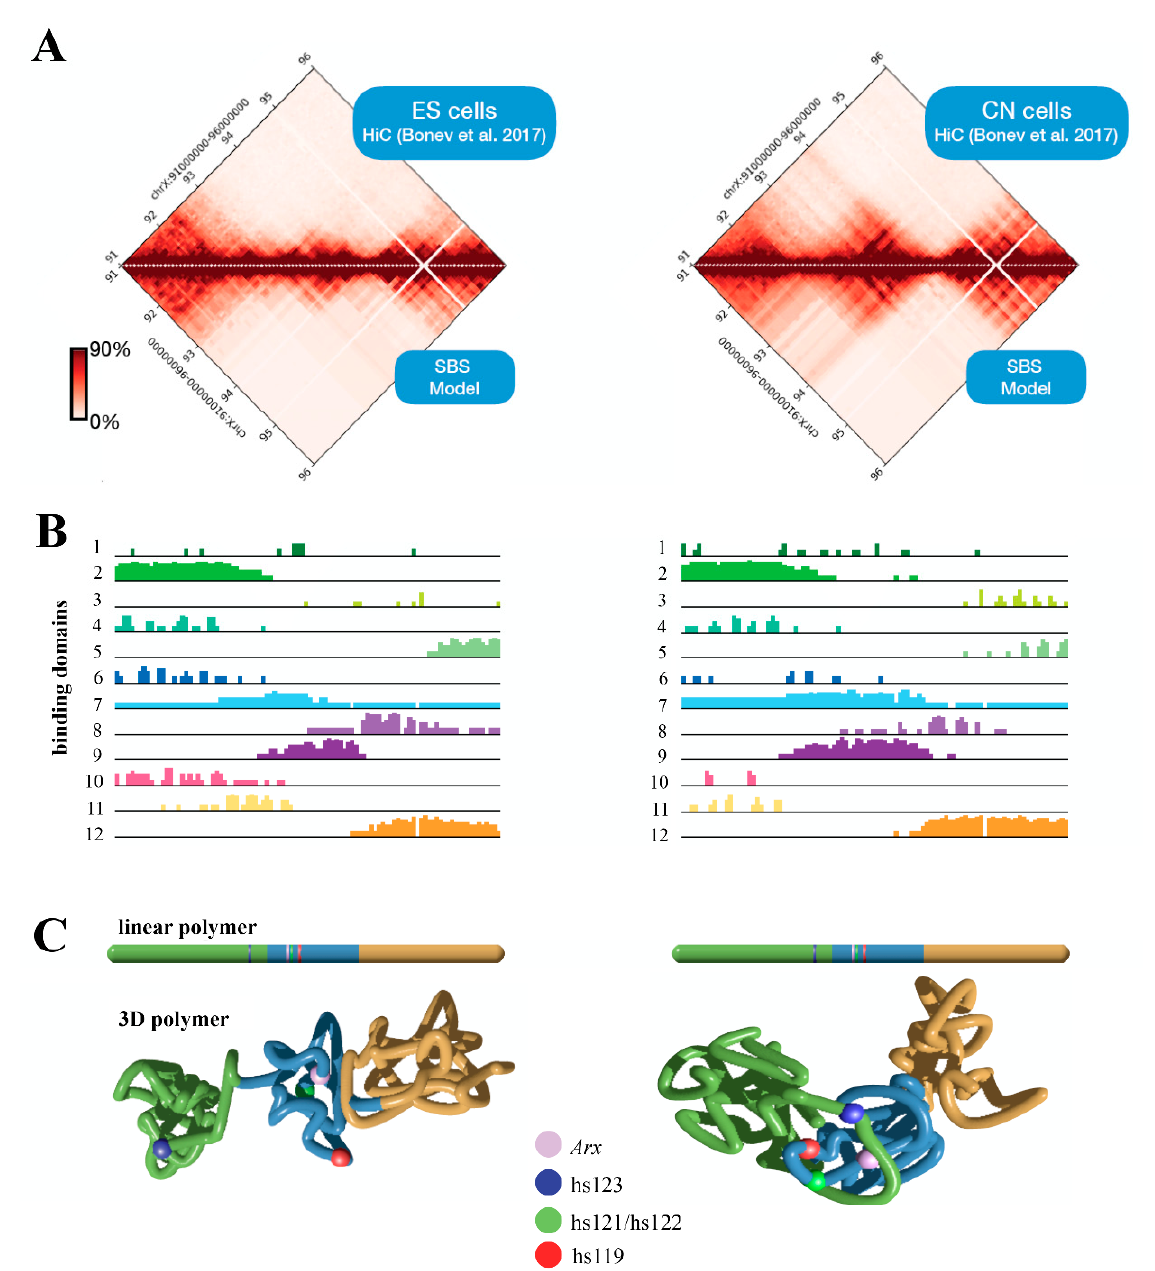
Figure 4. Polymer physics description of the murine Arx locus. Bottom matrices and contact maps predicted from the SBS polymer model by analysing the genomic region chrX:91,000,000–95,000,000 (UCSC, mm10). HiC data were obtained from a previous study [20] ( A ). Binding domain distributions for ESs (left) and CNs (right) ( B ). Snapshots from real MD simulations describing the 3D structure in ESs (left) and CNs (right). The colour scheme used is reported in the linear bar above ( C ).